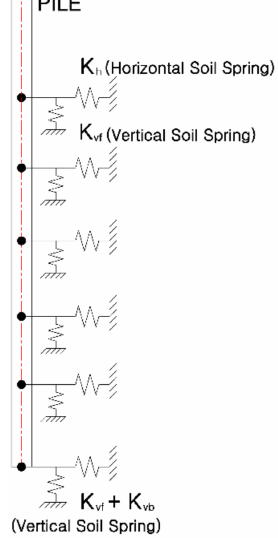
Figure 3. Soil spring model in the horizontal and vertical